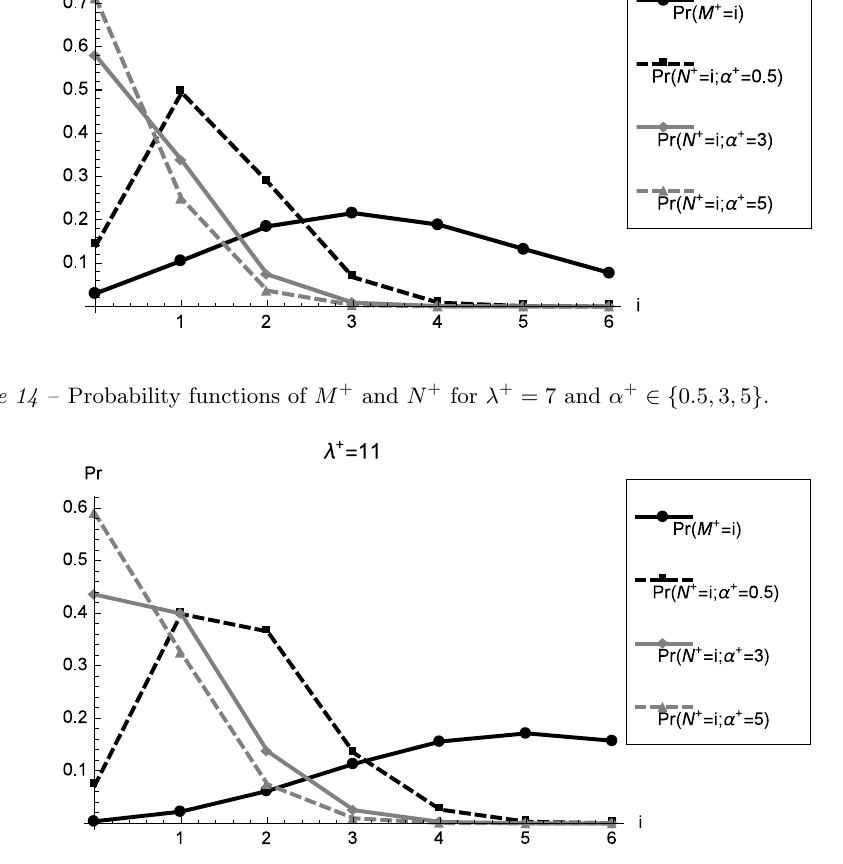
Figure 15 { Probability functions of M + and N + for (cid:21) + = 11 and (cid:11) + 2 f 0 : 5 ; 3 ; 5 g